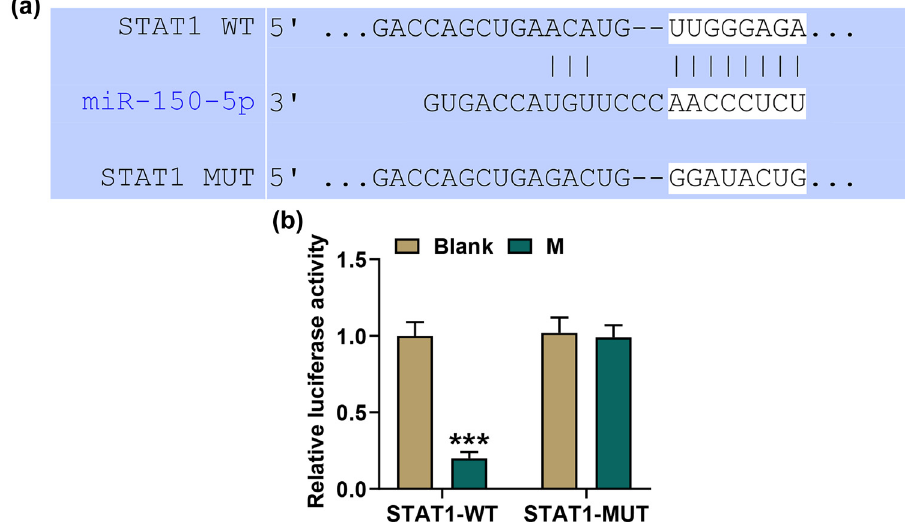
Figure 2: STAT1 was a direct target gene of miR - 150 - 5p. ( a ) Targetscan predicted that miR - 150 - 5p might bind to STAT1 mRNA. ( b ) The interaction between miR - 150 - 5p and STAT1 was con fi rmed by using a dual - luciferase reporter assay. HASMCs were co - transfected with the recombinant plasmid containing the STAT1 WT sequence ( WT ) or mutant sequence ( MUT ) with or without the miR - 150 - 5p mimic. M: miR - 150 - 5p mimic; Blank: cells were treated with PBS without transfection. *** p < 0.001 vs Blank. The luciferase reporter assay was repeated three times.